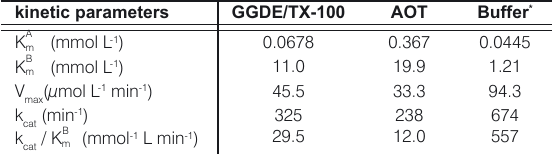
Based on the intercepts and slopes of lines in Fig. 4 or Fig. 6, the kinetic parameters K A m , K B figured out. These data, together with k are listed in Table 1. For comparison, the corresponding parameters in aqueous buffer solution are also given in Table 1. Kinetic parameters for YADH catalyzed oxidation of C in GGDE/TX-100 and AOT reverse